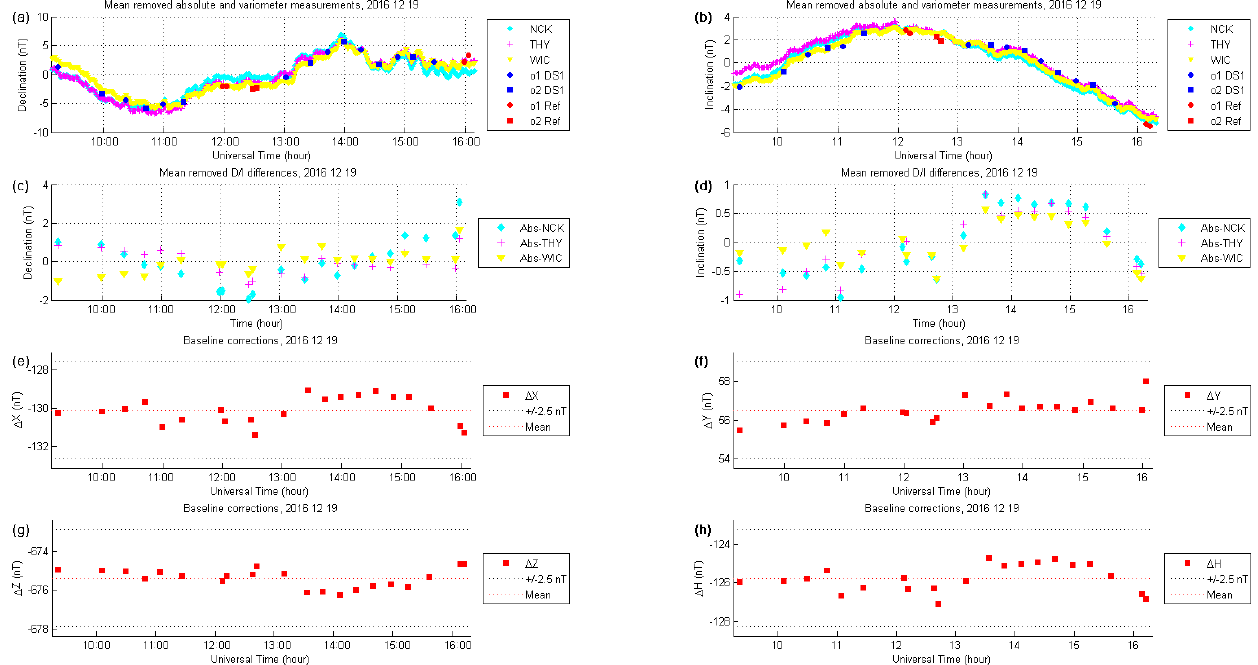
Figure 4. (a–b) The mean-removed declination and inclination values in nT unit. The circle and square marks refer to observations 1 and 2, respectively. The red colour corresponds to the absolute measurements with the reference instrument, while the blue corresponds to DS-1 equipment. The cyan diamond, magenta cross and the yellow triangles designate the calculated declination and inclination from the 1min variometer data of the NCK, THY and WIC observatories, respectively. (c–d) Difference between the absolute and averaged D , I angles. (e–h) The baseline corrections calculated from absolute data for the related components. The correction values accomplished the adopted confidence limit in the INTERMAGNET specification (definitive baseline data accuracy: ± 5nT) (St-Louis et al., 2012).